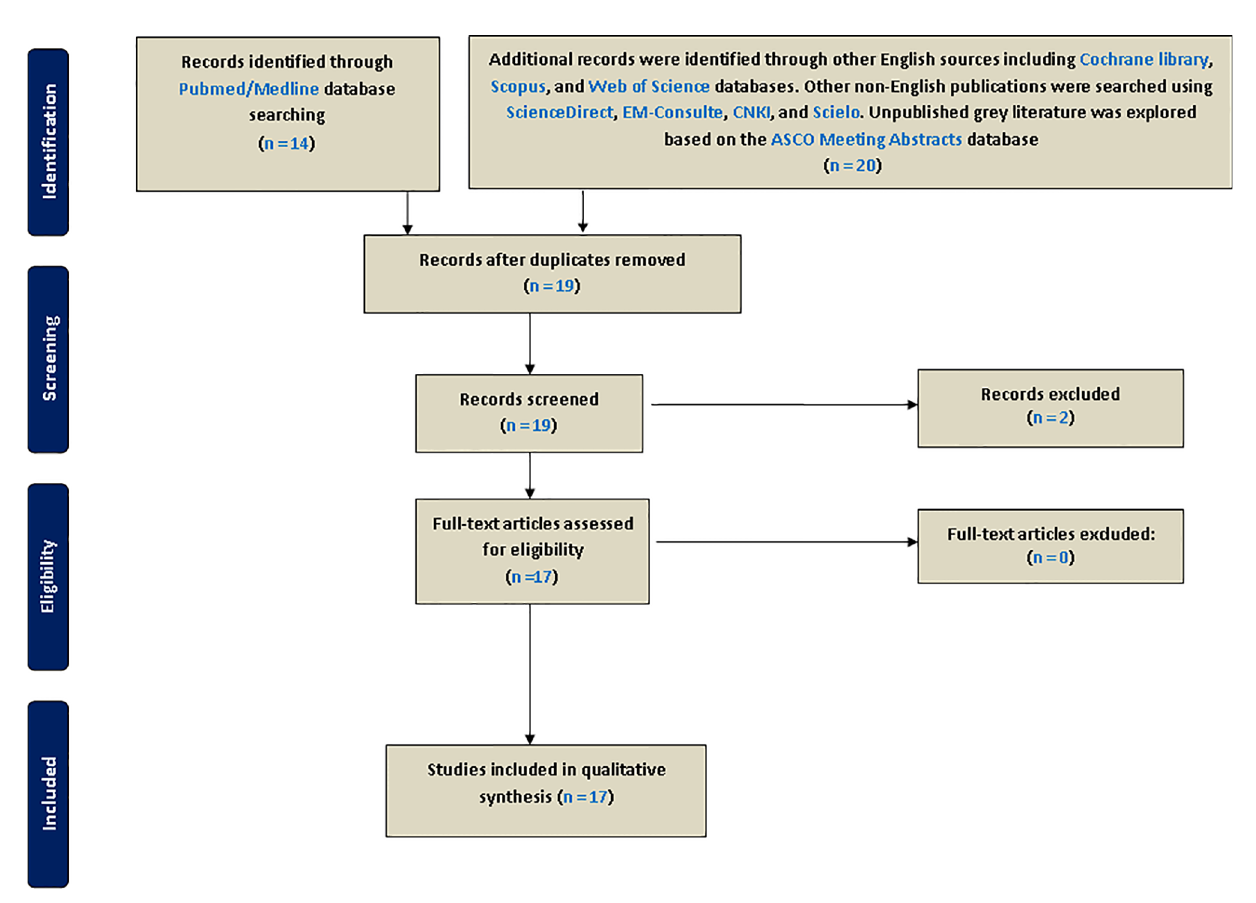
FIGURE 1 | Flow diagram of article